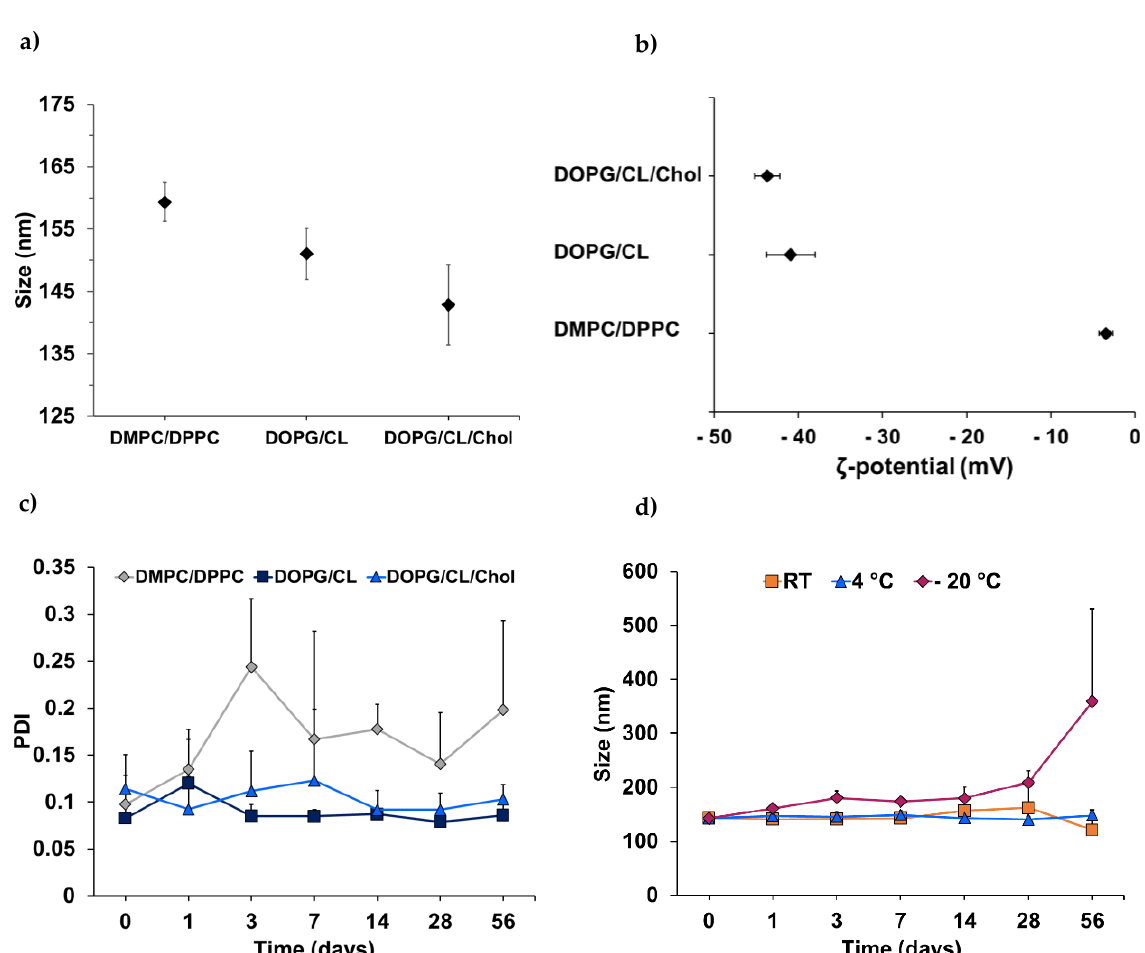
Figure 2. Stability assessment of bacteriomimetic liposomes: ( a ) average hydrodynamic diameter (nm) of liposomes in dispersion (PBS) as determined by DLS (Zetasizer Nano, Malvern, UK); ( b ) zeta potential (mV) of liposomes, measured in PBS; ( c ) polydispersity indices of bacteriomimetic and control (PC) liposomes stored at 4 °C over 8 weeks; ( d ) size development of DOPG/CL/Chol liposomes stored at room temperature (RT), 4 °C, and −20 °C for 8 weeks.